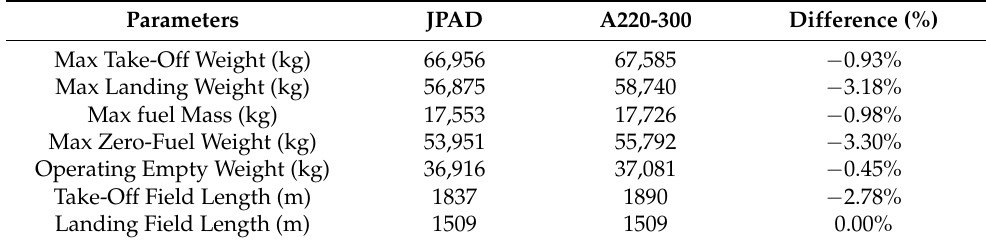
Table 13. Comparison between JPAD output and A220-330 data in Table 12, updated from